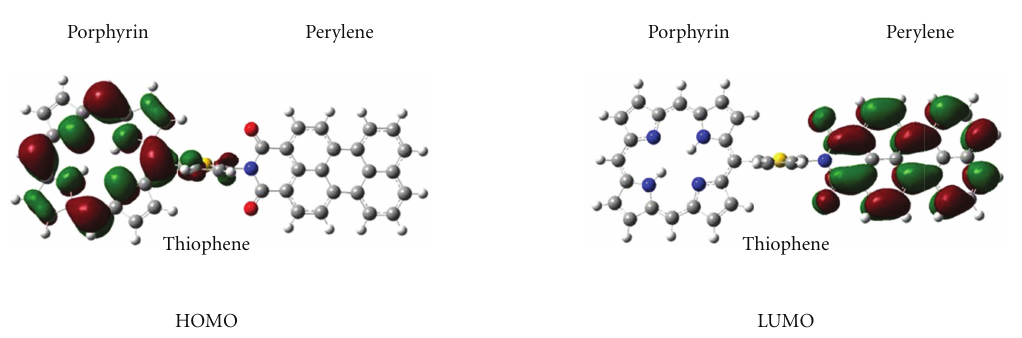
Figure 5: Frontier molecular orbital of PTP visualized by TD-B3LYP/6–31G(d) calculations indicated the electron donor and electron acceptor features of the porphyrin and perylene units,